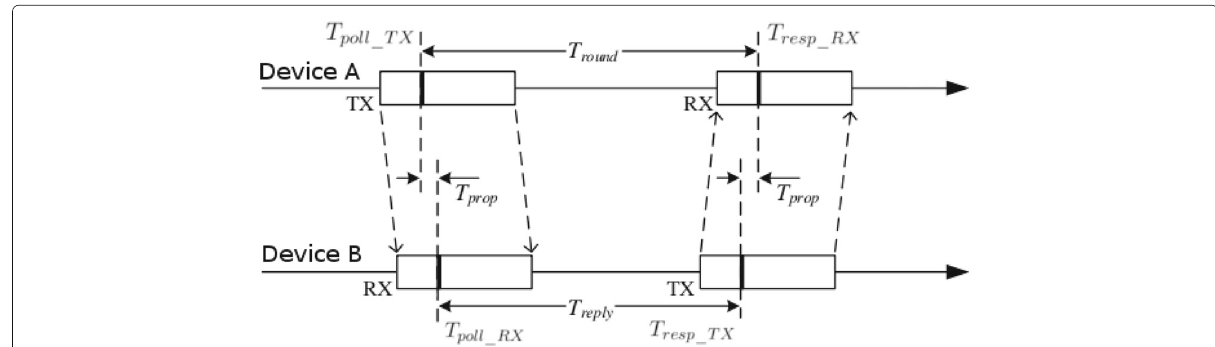
Fig. 1 Single-sided TWR ranging scheme where T poll_TX , T poll_RX , T resp_TX and T resp_RX represent four ranging timestamps that can be used for ToF calculation